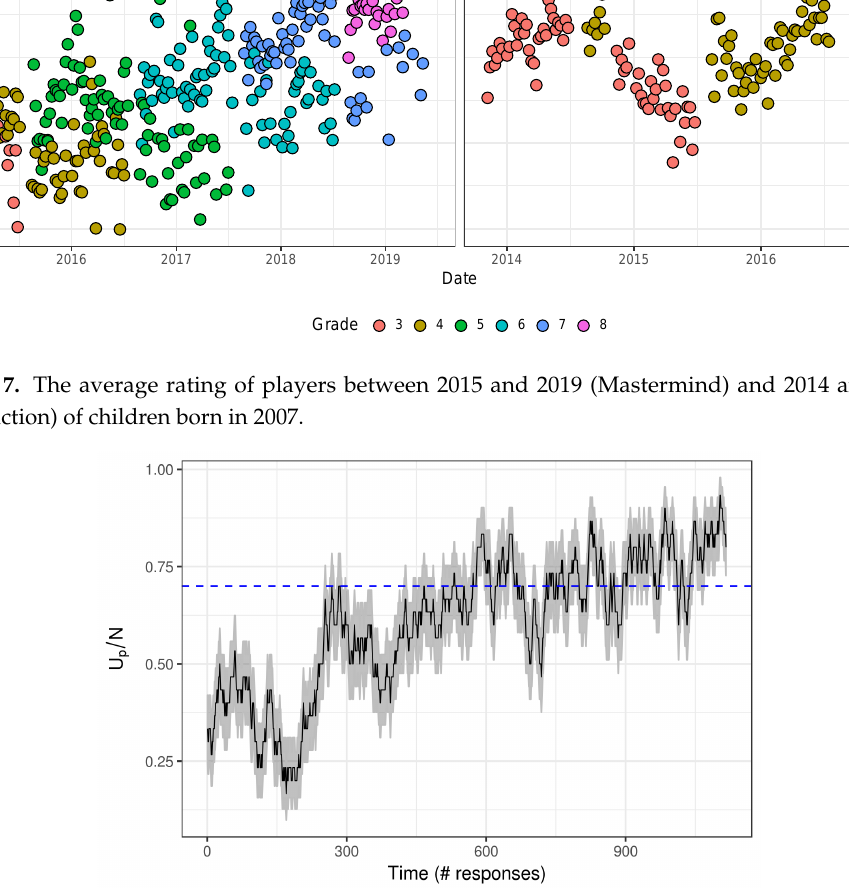
Figure 8. The rating development (and the CI in grey) of a player. The horizontal line at Up / N = 0.7 indicates an (arbitrary) reference point that could indicate a sufficient ability in the subtraction